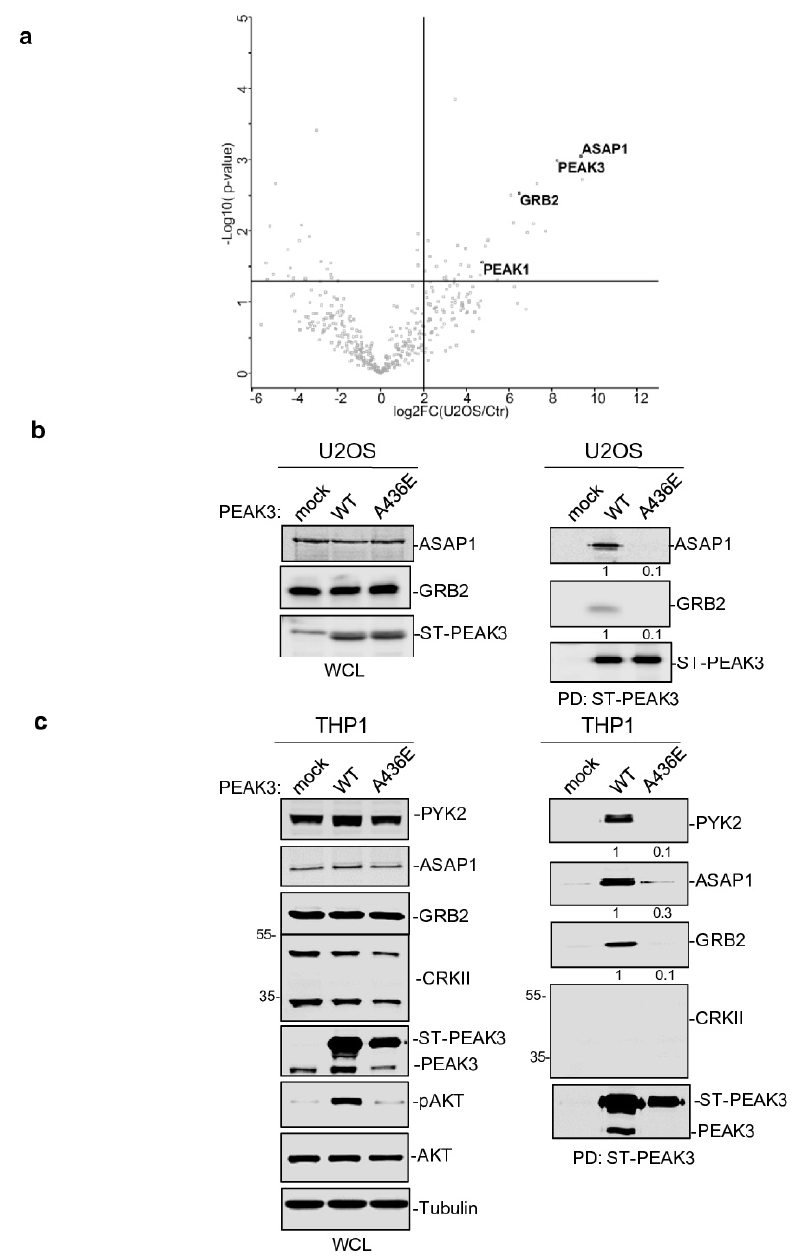
Figure 5. PEAK3 interactomics identified GRB2, ASAP1/2, and PYK2 as SHED-dependent binders. ( a ) Interactome of PEAK3 in U2OS cells represented as volcano plots of the MS data ( n = 3). ( b ) and ( c ) Validation by western blot analysis of PEAK3 interaction with the indicated signaling proteins in U2OS ( b ) and THP1 cells ( c ) ( n = 2). The relative levels of PYK2, ASAP1, and GRB2 associated with ST-PEAK3 WT and AE mutant are shown.